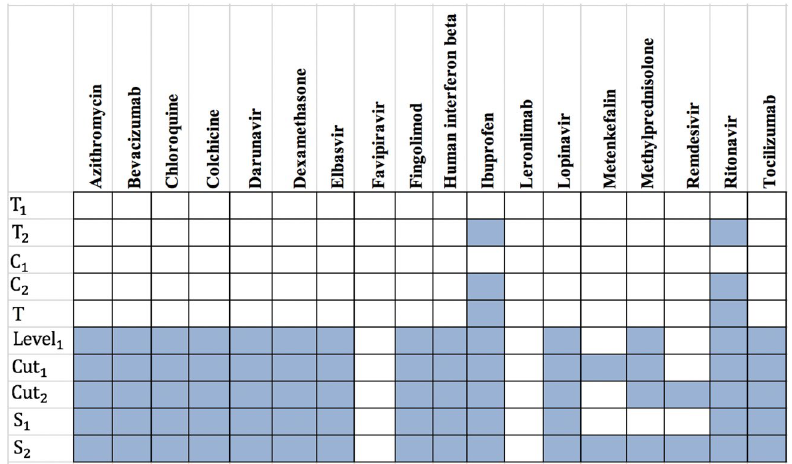
Figure 4. The presence (blue color) or absence (white color) of the overlap of proteins targets of T 1 , T 2 , C 1 , C 2 T , Level Cut Cut S S 1 , 1 , 2 , 1 and 2 sets with the targets of Covid-Drug. The complete description of sets is presented in Table